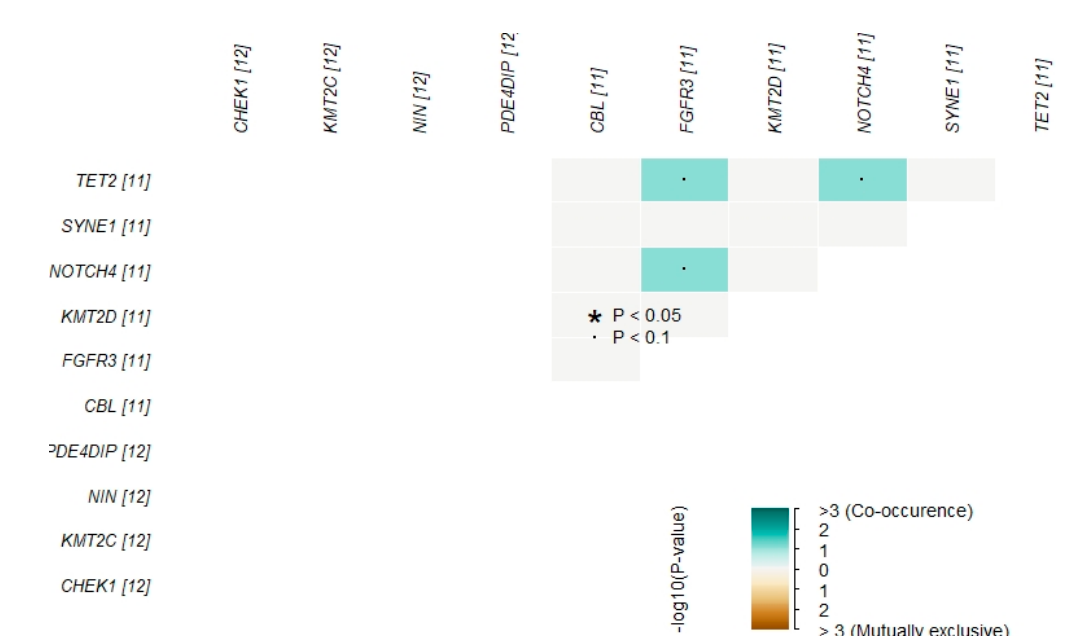
Figure 5. Pair-wise Fisher’s Exact test analysis of top 10 highly mutated genes to detect mutually exclusive or co-occurring events. * p < 0.05, · p < 0.1.